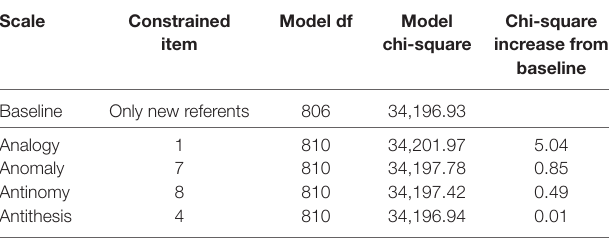
taBlE 11 | Likelihood-ratio tests for differential item functioning between white and asian participants: testing